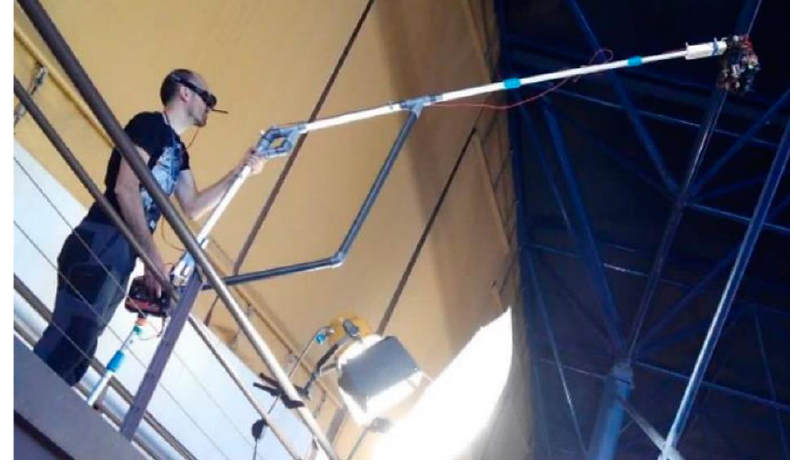
Figure 3. Pole system with a Canon EOS 5D MARK II embarked on it for the photogrammetric survey of the “Cueva Pintada”.